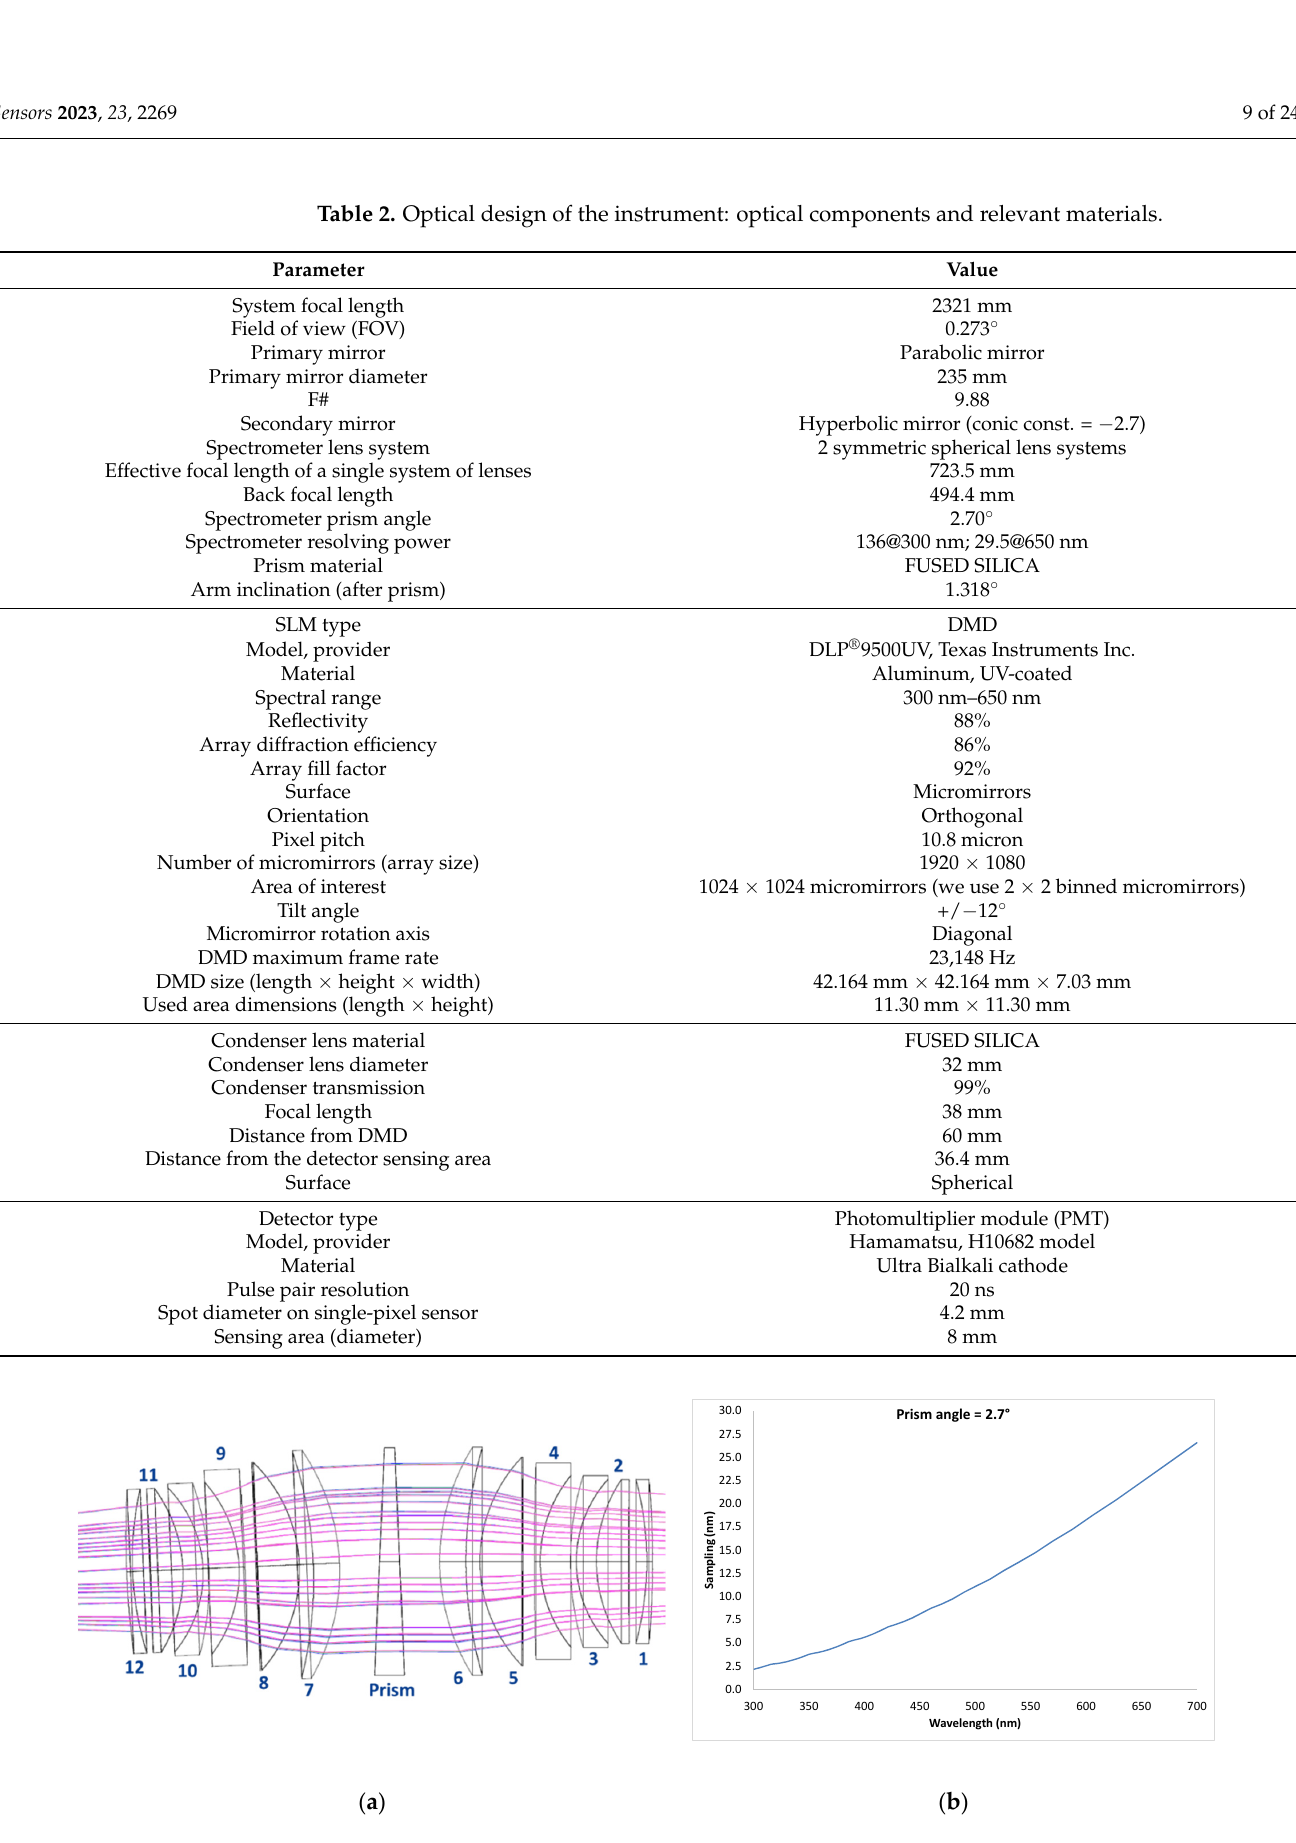
Figure 4. Optical design of the CS instrument: ( a ) spectrometer layout and ( b ) corresponding spectral sampling curve.